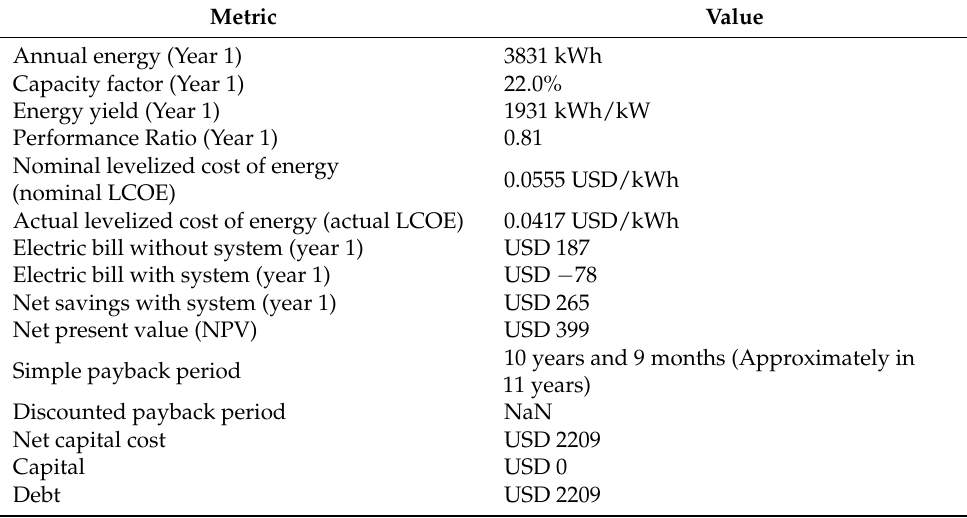
Table 5. Summary of metric values associated with the PV under study.